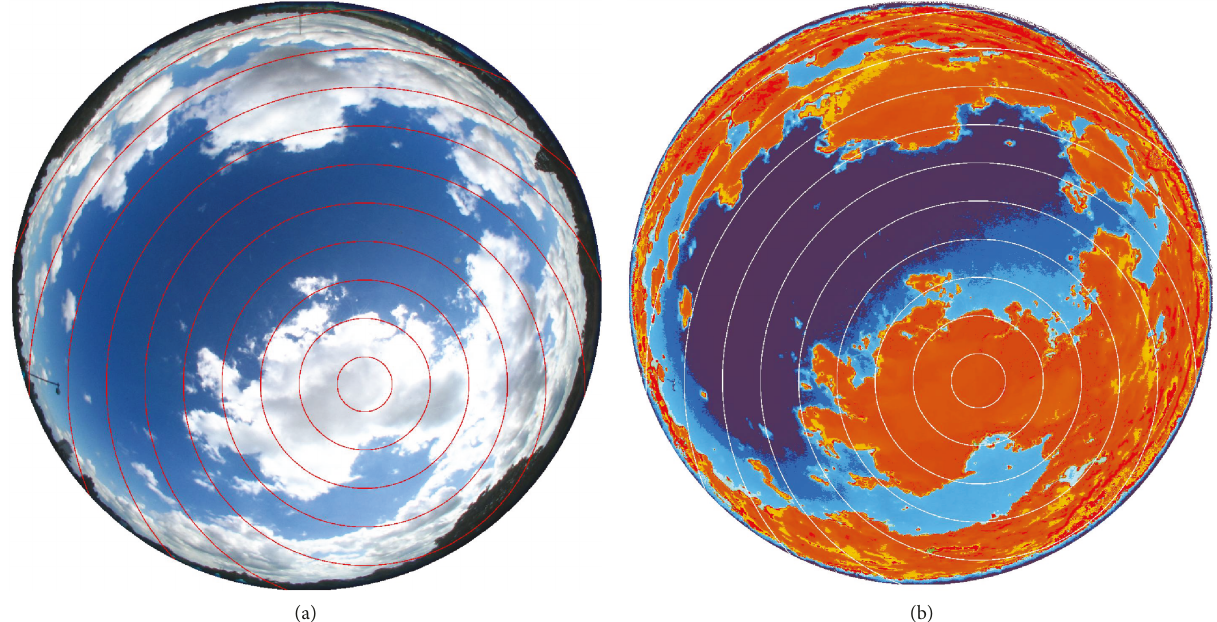
Figure 3: (a) shows the 10 circles on 22nd June 2014 at 12:51 on the original image. (b) shows 10 circles on 22nd June 2014 at 12:51 on the Haze Index